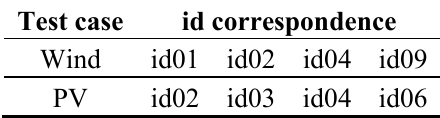
Table 2. List of participants with correspondences between wind and PV test